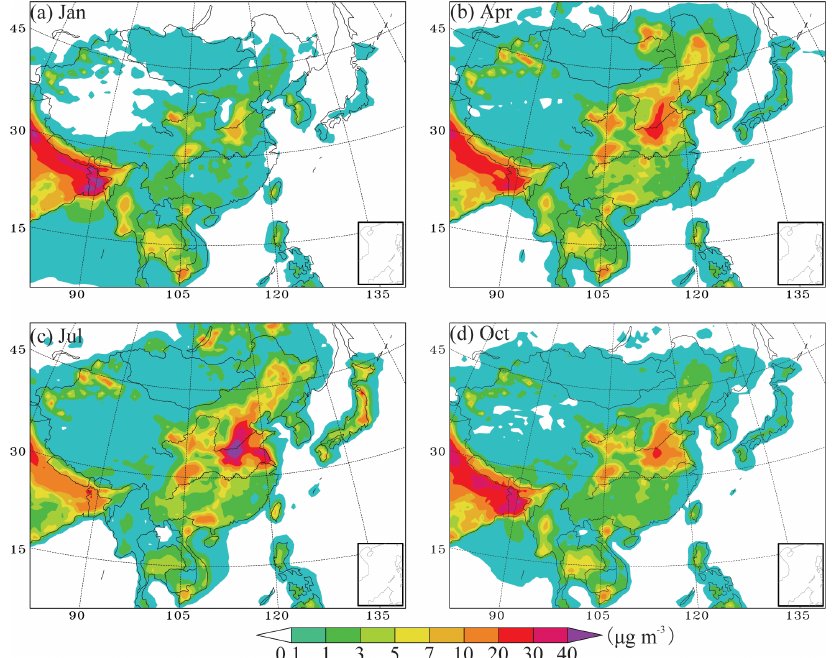
Figure 3. The horizontal distributions of the modeled monthly NH 3 mass concentration in January, April, July, and October in